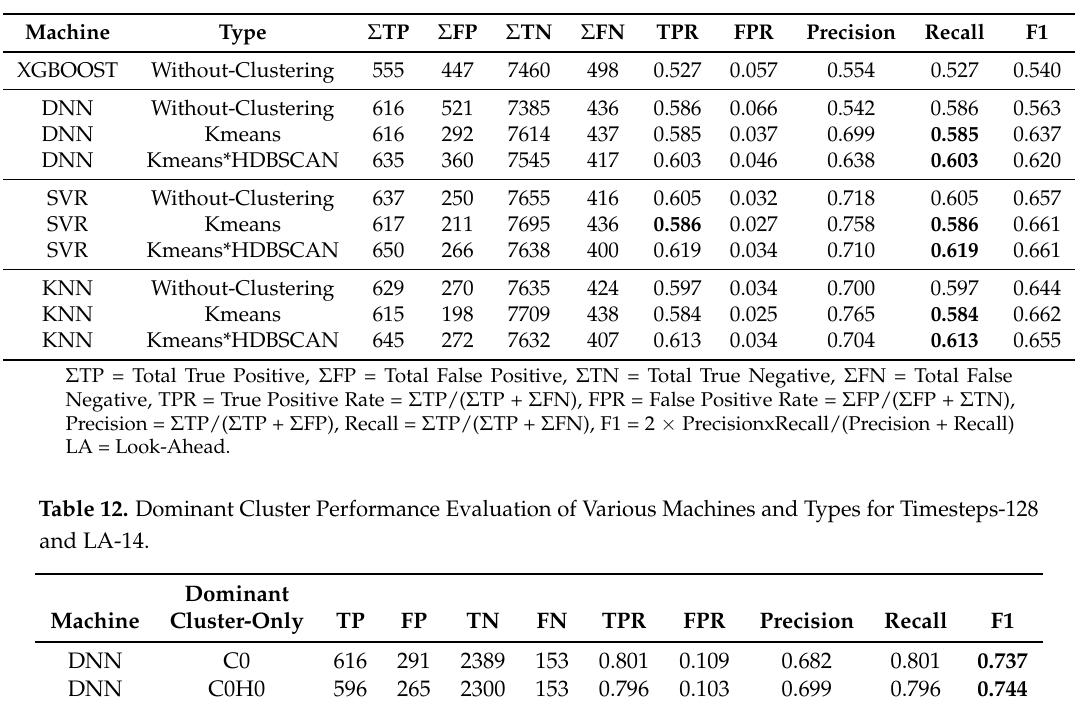
Table 11. All Clusters Performance Evaluation of Various Machines and Types for Timesteps-128 and LA-14.